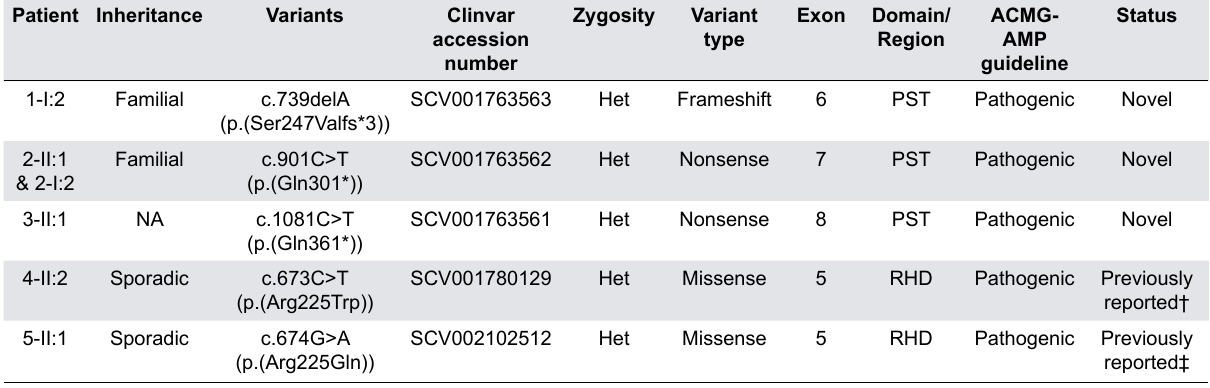
Table 2- The heterozygous RUNX2 variants identified in the CCD